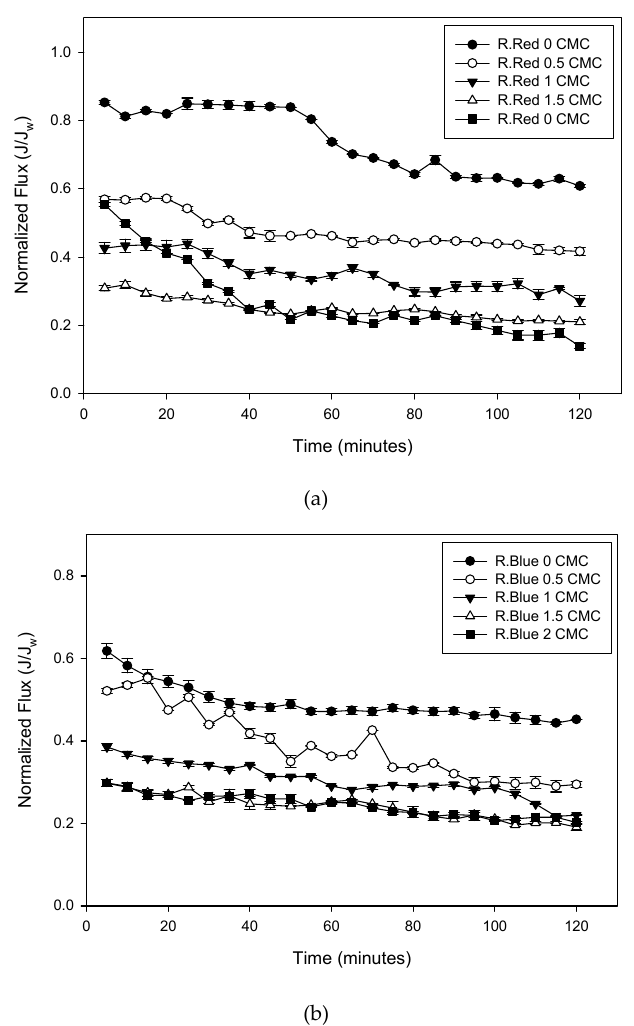
Figure 3. Variation of the observed permeate fluxes of ( a ) Remazol Red RB and ( b ) Turquoise Blue, at various saponin concentrations, with time, at room temperature, a pressure of 1.5 bars and a dye concentration of 300 ppm.